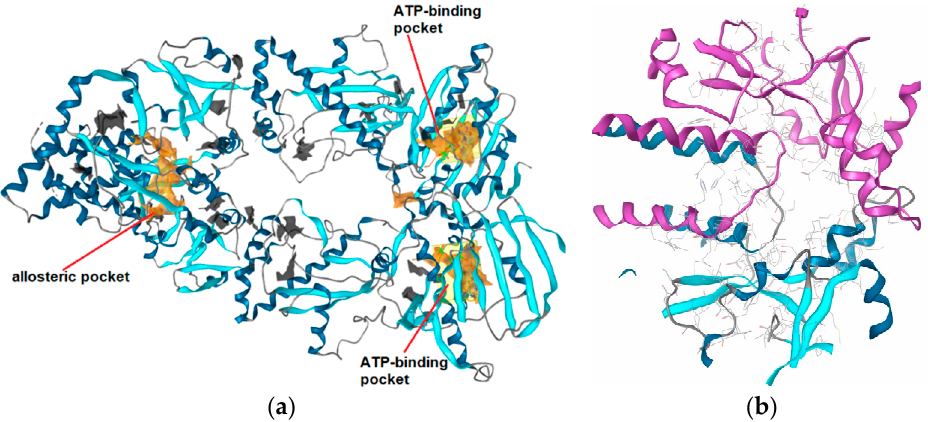
Figure 4. ( a ) Identification of putative binding pockets in Hsp90 β cryoEM structure (PDB Code: 5FWK). The orange isosurfaces represent prioritized pockets identified by LigandScout 4.3. Two predicted pockets correspond to the ATP-binding sites in N-terminal domain of each Hsp90 monomer. A third large orange isosurface represents the allosteric pocket at the interface of two C-terminal domains. ( b ) Predicted allosteric pocket in the Hsp90 CTD at the interface of monomer A (magenta) and monomer B (blue) that was prioritized for docking, molecular dynamics and structure-based (SB)-pharmacophore modeling studies.